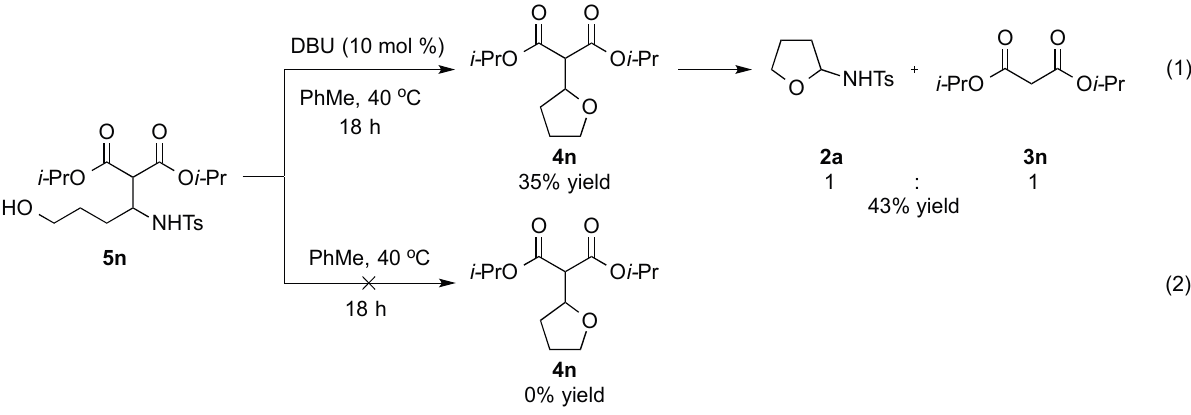
Scheme 3. Control experiments with 5n in the absence and presence of